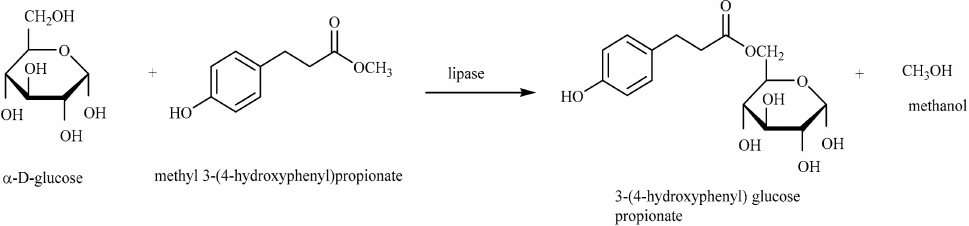
Scheme 1. Transesterification reaction of α - d -glucose with methyl 3- (4-hydroxyphenyl) propionate (HPPME), catalyzed by lipases.